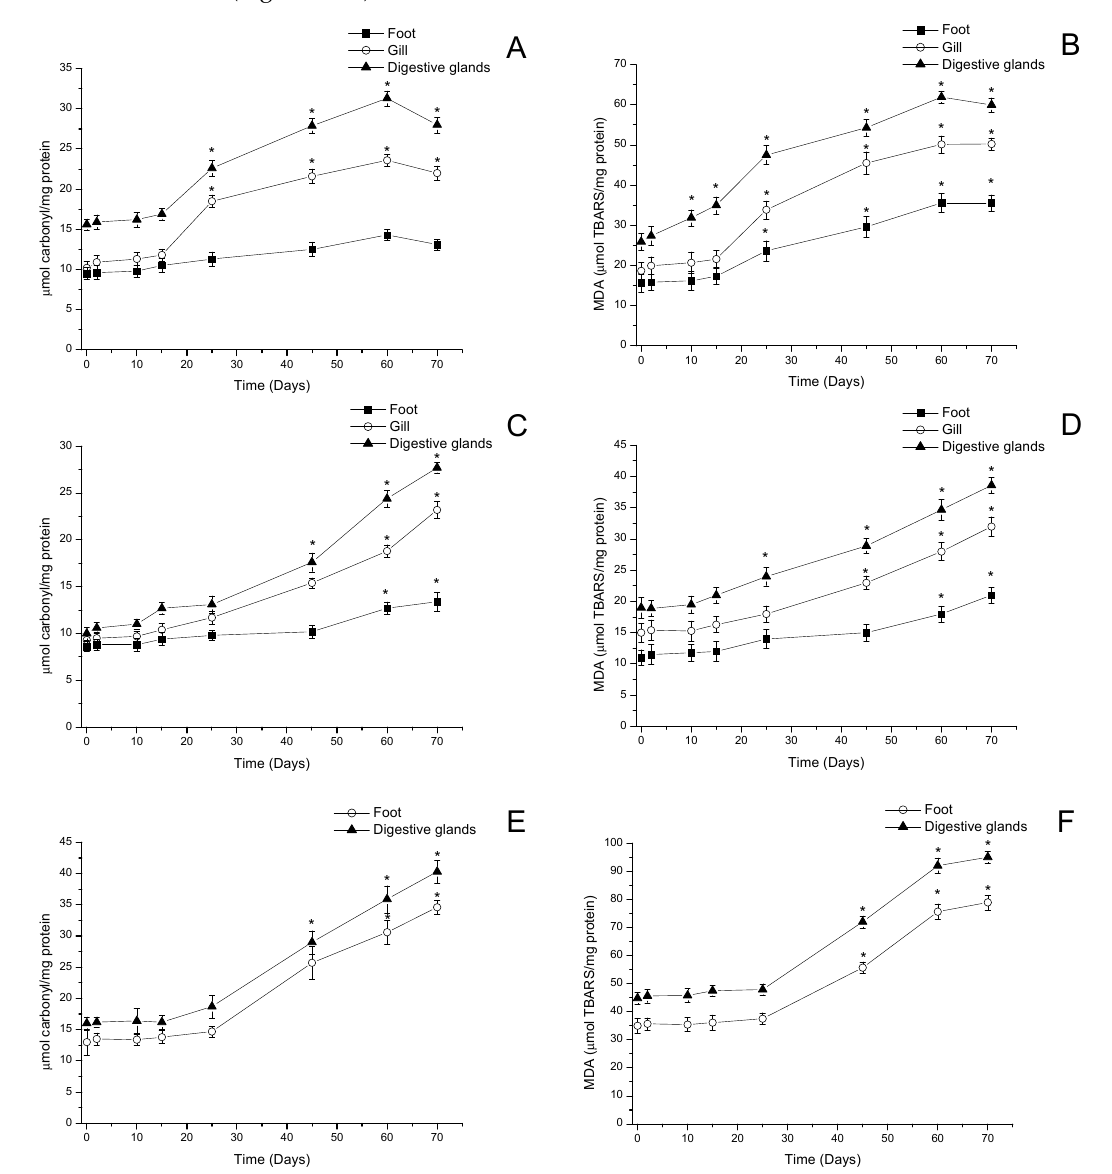
Figure 7. Protein oxidation (carbonyl content) and lipid peroxidation (MDA) in feet, gills, and digestive glands of ( A , B ) mussels ( Mytilus chilensis ), ( C , D ) clams ( Ameghinomya antiqua ), and ( E , F ) feet and digestive glands of locos ( Concholepas concholepas ) during a bloom of Alexandrium pacificum . Data are presented as the mean ± SEM. For significant differences compared to control (time point 0), values are indicated by an asterisk (*) in the data ( p < 0.05; Dunnett’s test).